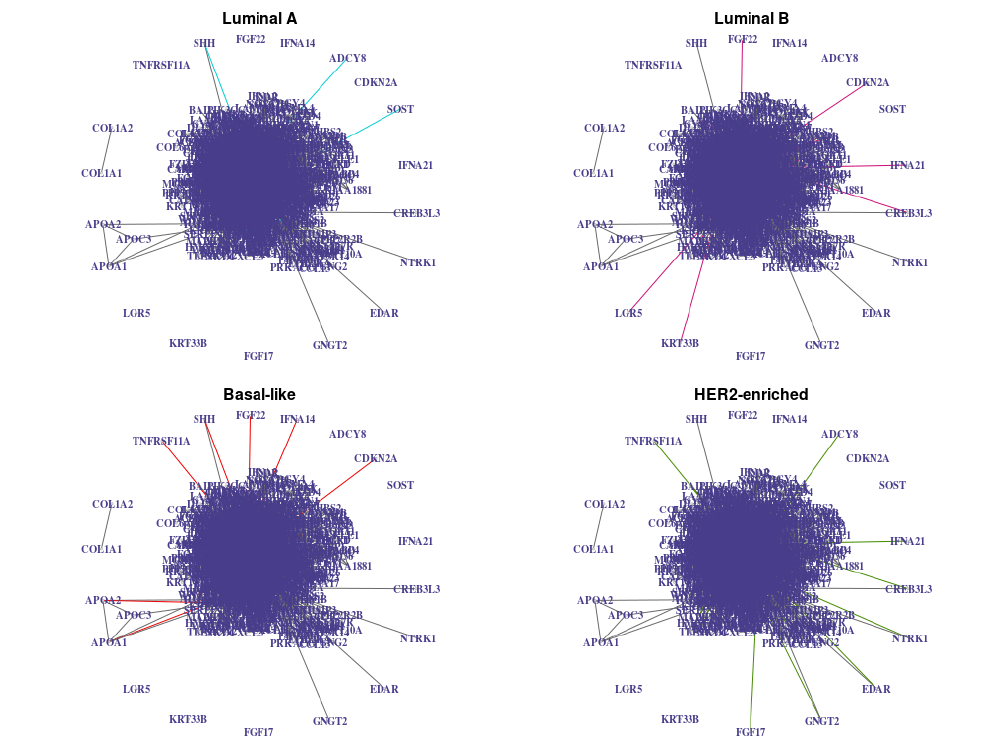
Figure 9. Networks estimated with jewel 2.0 with λ 1 = 0.35, with weights derived from the prior information (27 (3% of p = 900) vertices with the highest degree in the STRING networks are identified as “hubs” with degree 10, all other vertices have degree 1) and with stability procedure ( #subsets = 25, chosen fraction = 0.8). Edges common to all K = 4 graphs are in grey, and class-specific edges are colored. Note that vertices that are isolated in the union of these graphs are not plotted for